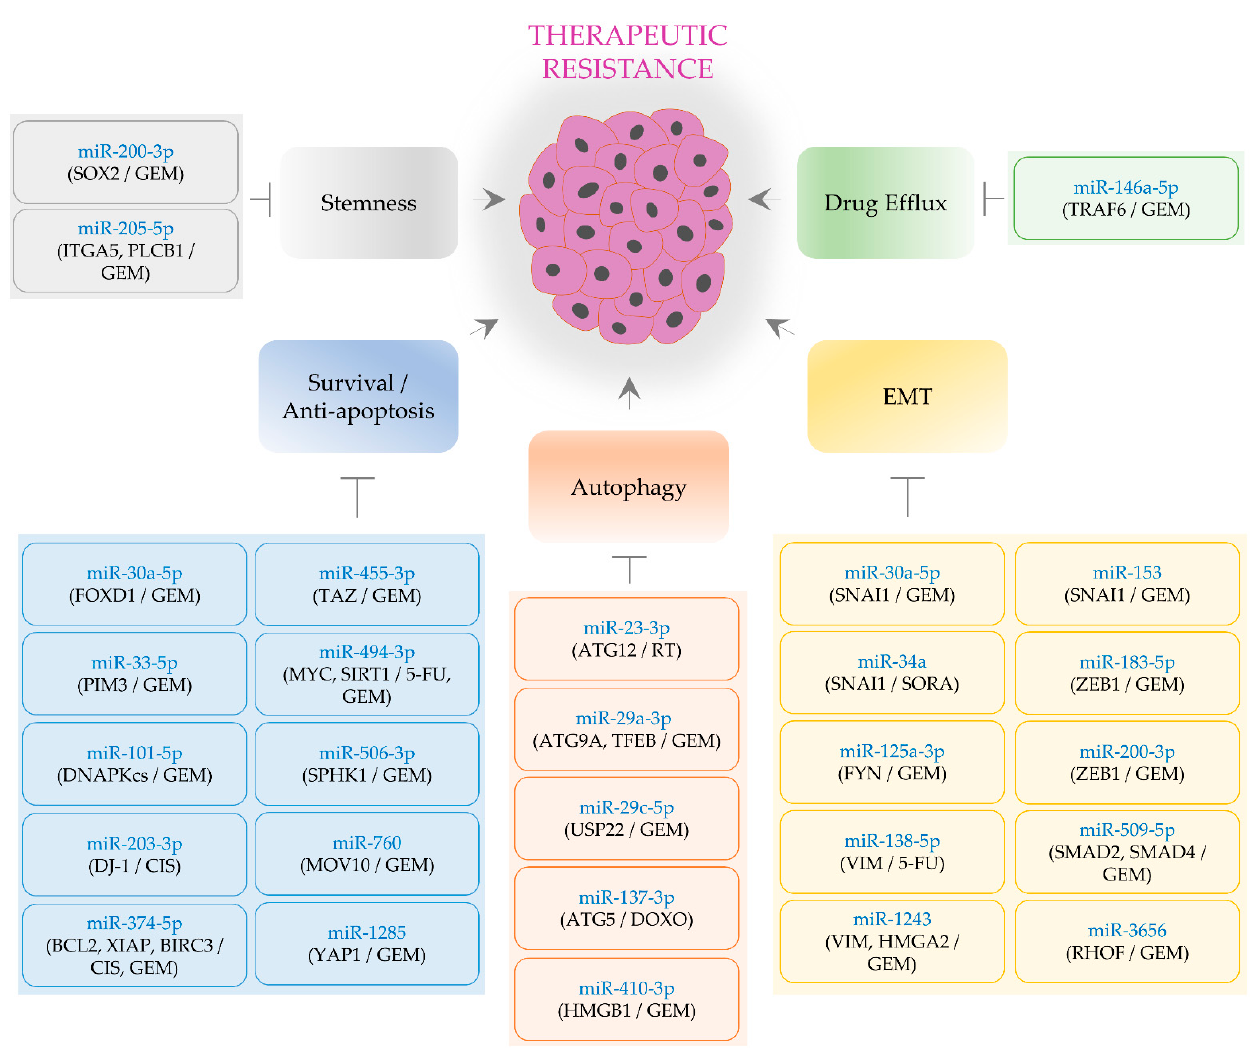
Figure 2. MiRNA-mediated repression of therapeutic resistance in PaC. Tumor-suppressive miRNAs in rounded rectangles are shown in blue. Round brackets denote target genes of miRNAs and then therapeutic agents affected by miRNAs. Activation is indicated by an arrow. Inhibition is denoted by a perpendicular line. GEM: gemcitabine; 5-FU: 5-fluorouracil; PTX: paclitaxel; CIS: cisplatin; RT: radiotherapy; DOXO: doxorubicin; SORA: sorafenib. Table 2. Tumor-suppressive miRNAs that abate therapeutic resistance in PaC.